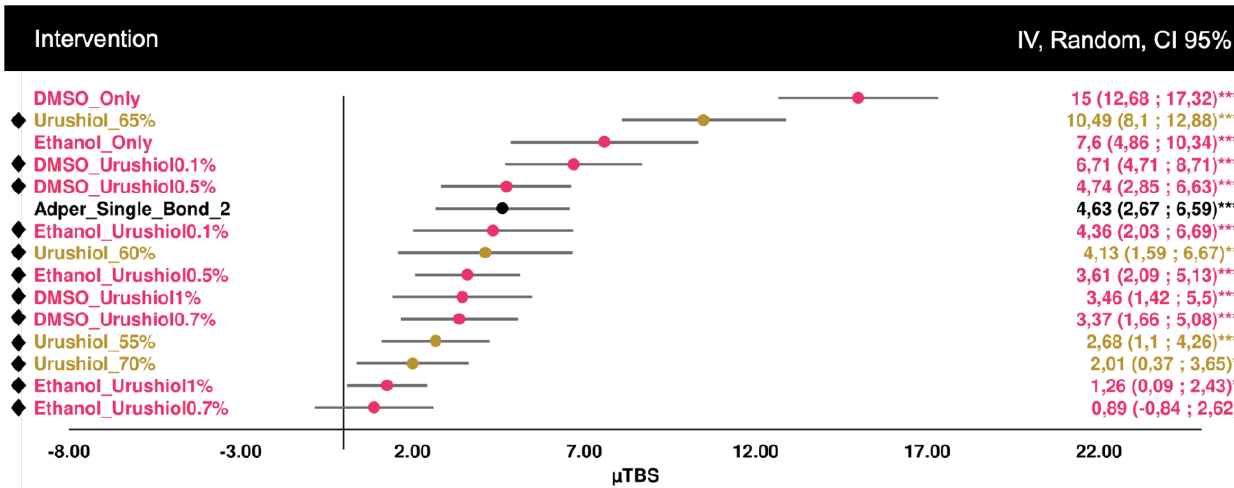
Figure 3. Forest plot of the bond strength difference after real aging in distilled water (6 months), by subtracting the final from the initial bond strength value. Symbol legend: ★ eugenyl methacrylate derivatives; ● methacrylamide derivatives. Statistical significance (difference to 0) is shown in asterisks, where * p ≤ 0.05 ** p ≤ 0.01 *** p ≤ 0.001.